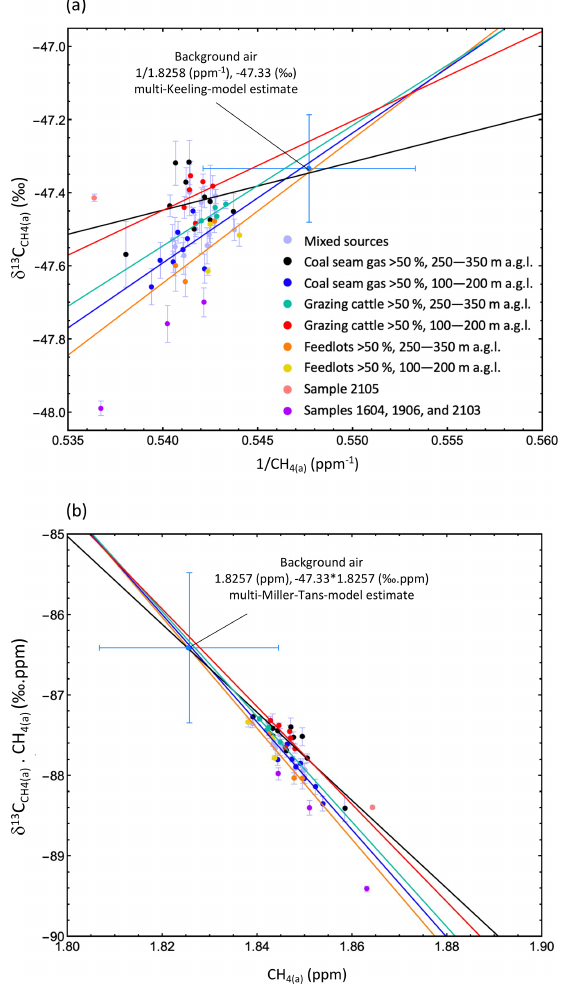
Figure B1. Least squares regression for two-endmember mixing models fitted to individual source category data sets using (a) the Keeling model (Eq. 1) and (b) the Miller–Tans model (Eq. 2). For reference the background-air values for CH 4(b) and δ 13 C CH termined from the multi-Keeling and multi-Miller–Tans-model re- gressions are displayed in (a) and (b) , respectively. The regression statistics for each category are listed in Table B1. Both graphs high- light that when the models are fitted to the individual source cat- egory data sets, the lines of best fit do not converge to a common value for background air. All error bars are 1 standard